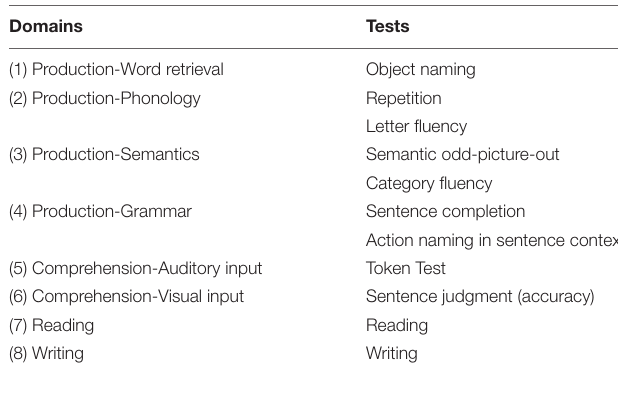
TABLE 1 | Language domains under investigation with their corresponding